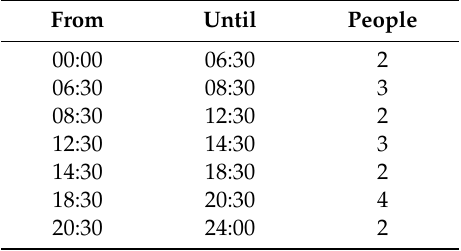
Table 3. Occupancy schedule of the patient room defined on the basis of visiting hours. From Until People